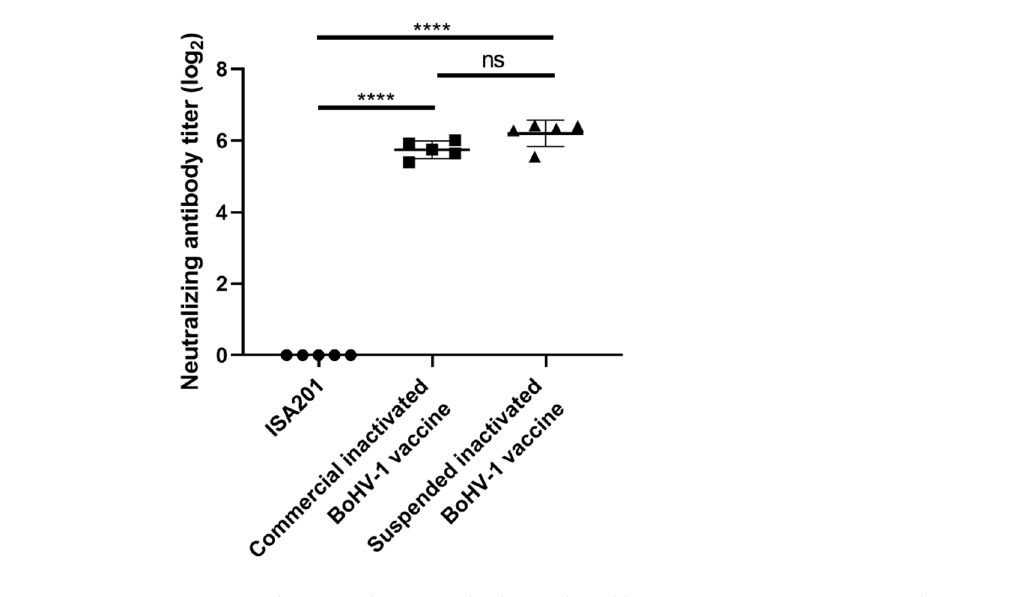
Figure 6. The neutralizing antibodies induced by ISA201, BoHV-1 inactivated vaccine manufactured in suspended MDBK cells and commercial inactivated BoHV-1 vaccine, significance code: “****” representing p < 0.0001, “ns” for no significant difference.